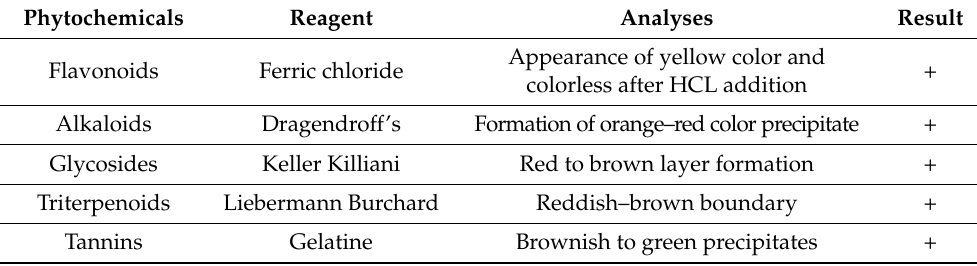
Table 1. Preliminary qualitative phytochemicals screening of Cydonia oblonga Met + Ext. Phytochemicals Reagent Analyses Result Appearance of yellow color and Flavonoids Ferric chloride + colorless after HCL addition Alkaloids Dragendroff’s Formation of orange–red color precipitate + Glycosides Keller Killiani Red to brown layer formation + Triterpenoids Liebermann Burchard Reddish–brown boundary + Tannins Gelatine Brownish to green precipitates